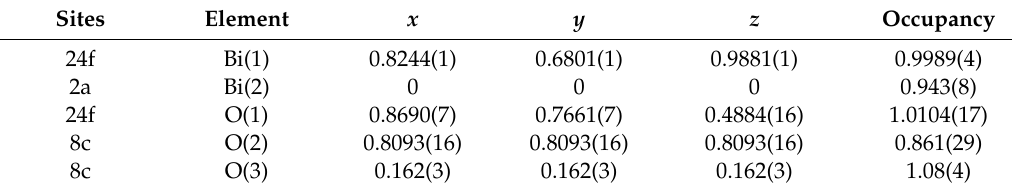
1 lattice parameter a = b = c = 10.1115(1) Å; volume V = 1033.82(3) Å 3 ; Space group I23 (No. 197); wR(%) = 2.460; goodness of fitting (GOF) (%) =